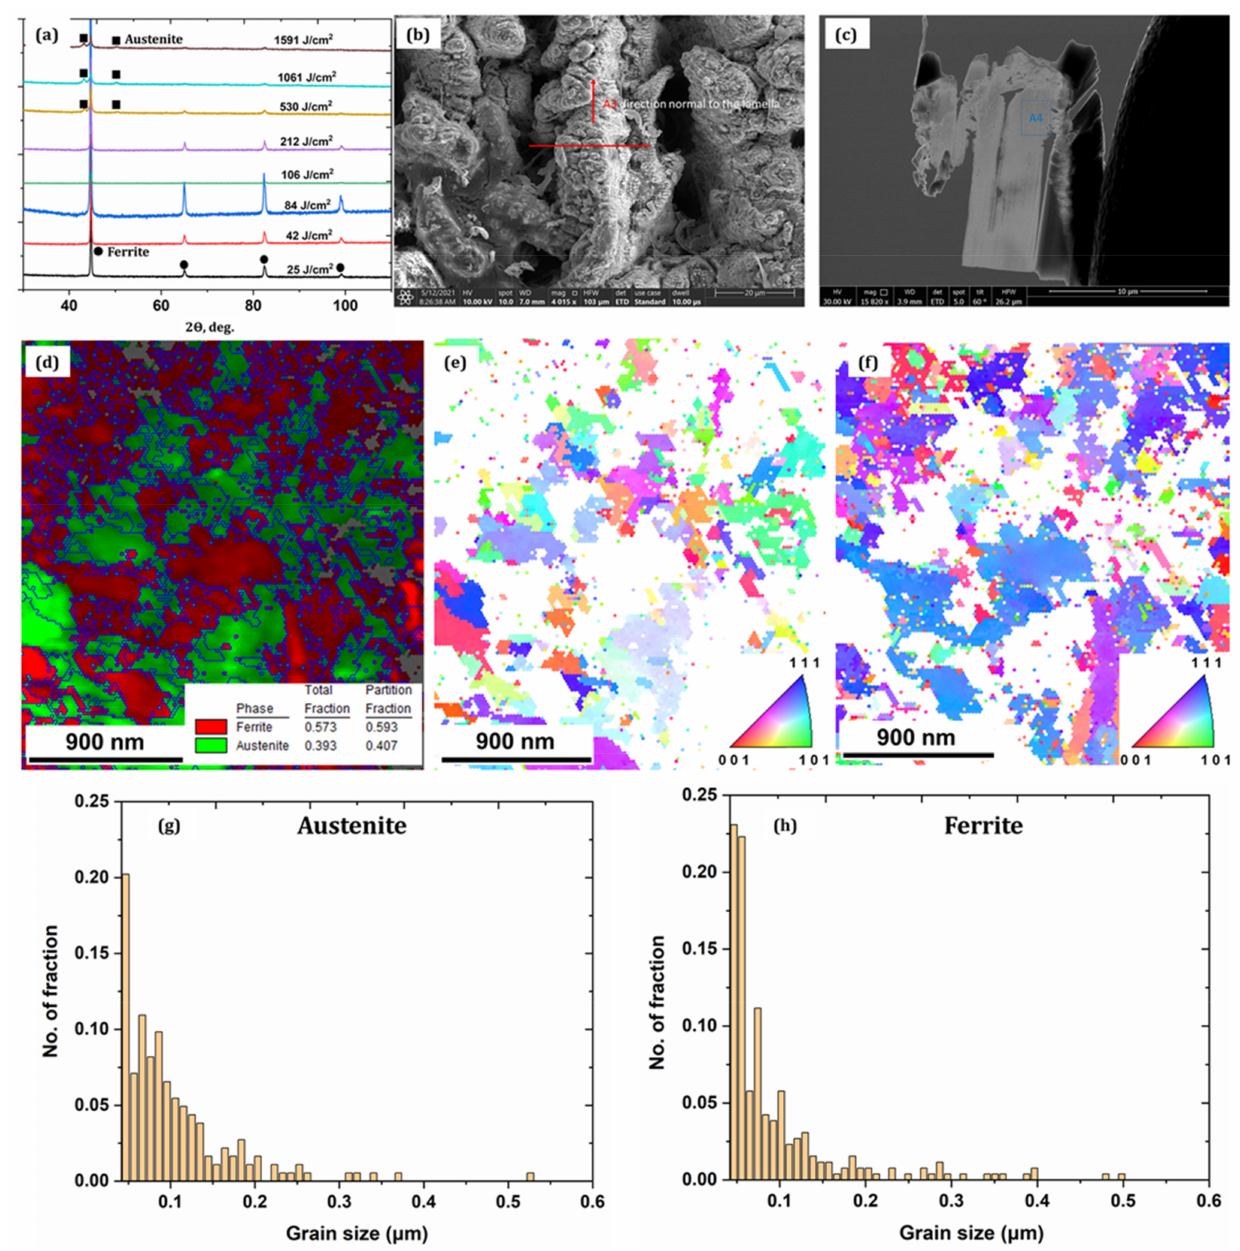
Figure 2. ( a ) XRD spectrum for the samples irradiated at several CH; ( b ) A sample morphology irradiated at 1561 J/cm 2 used for the EBSD sample preparation; ( c ) cross-section lamella taken using FIB; ( d ) EBSD phase analysis that showed the presence of the austenite phase; ( e , f ) EBSD inverse pole map for the austenite and ferrite phases, respectively; ( g , h ) grain size distribution of the austenite and ferrite phases,